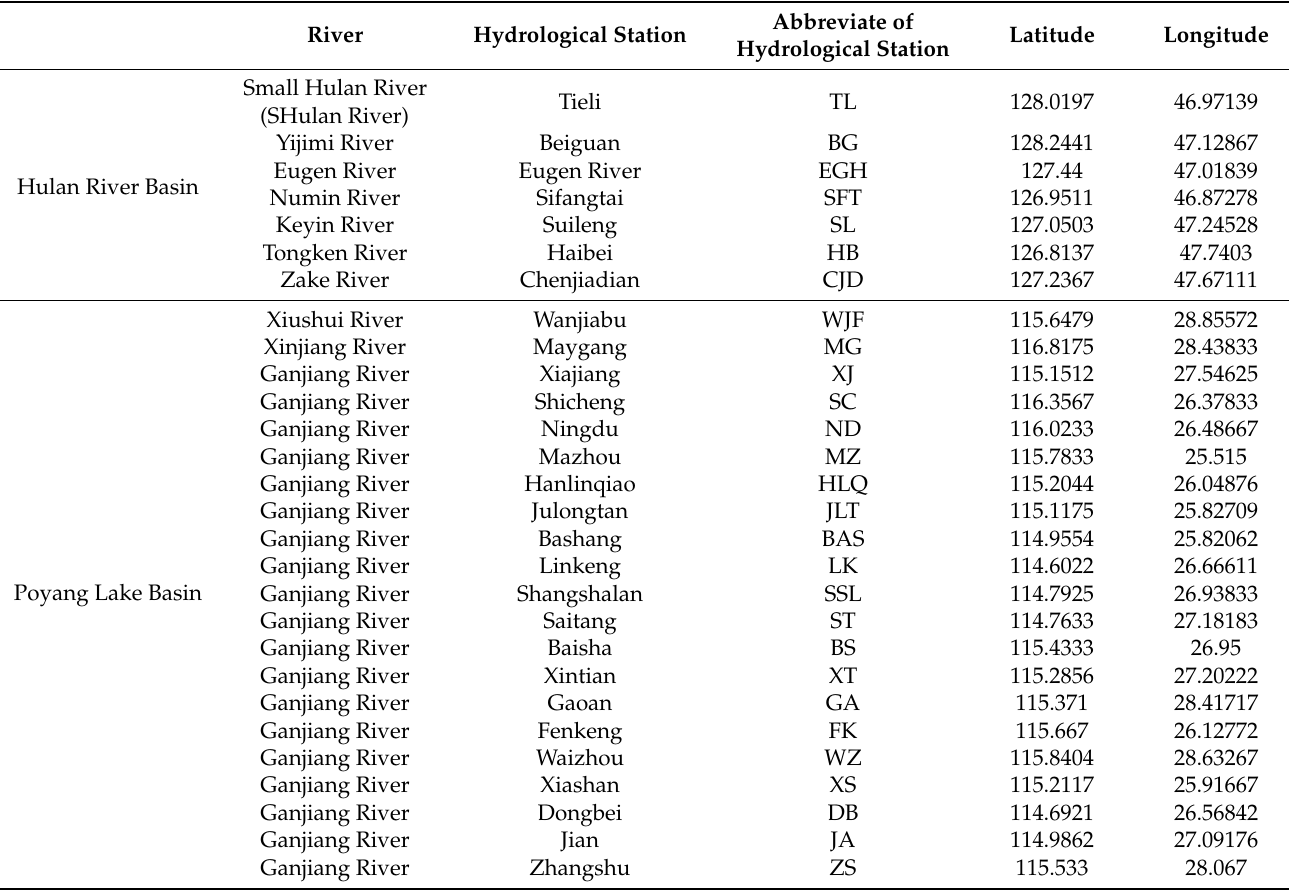
Table 1. Information on the Hulan River Basin and Poyang Lake Basin and their hydrological